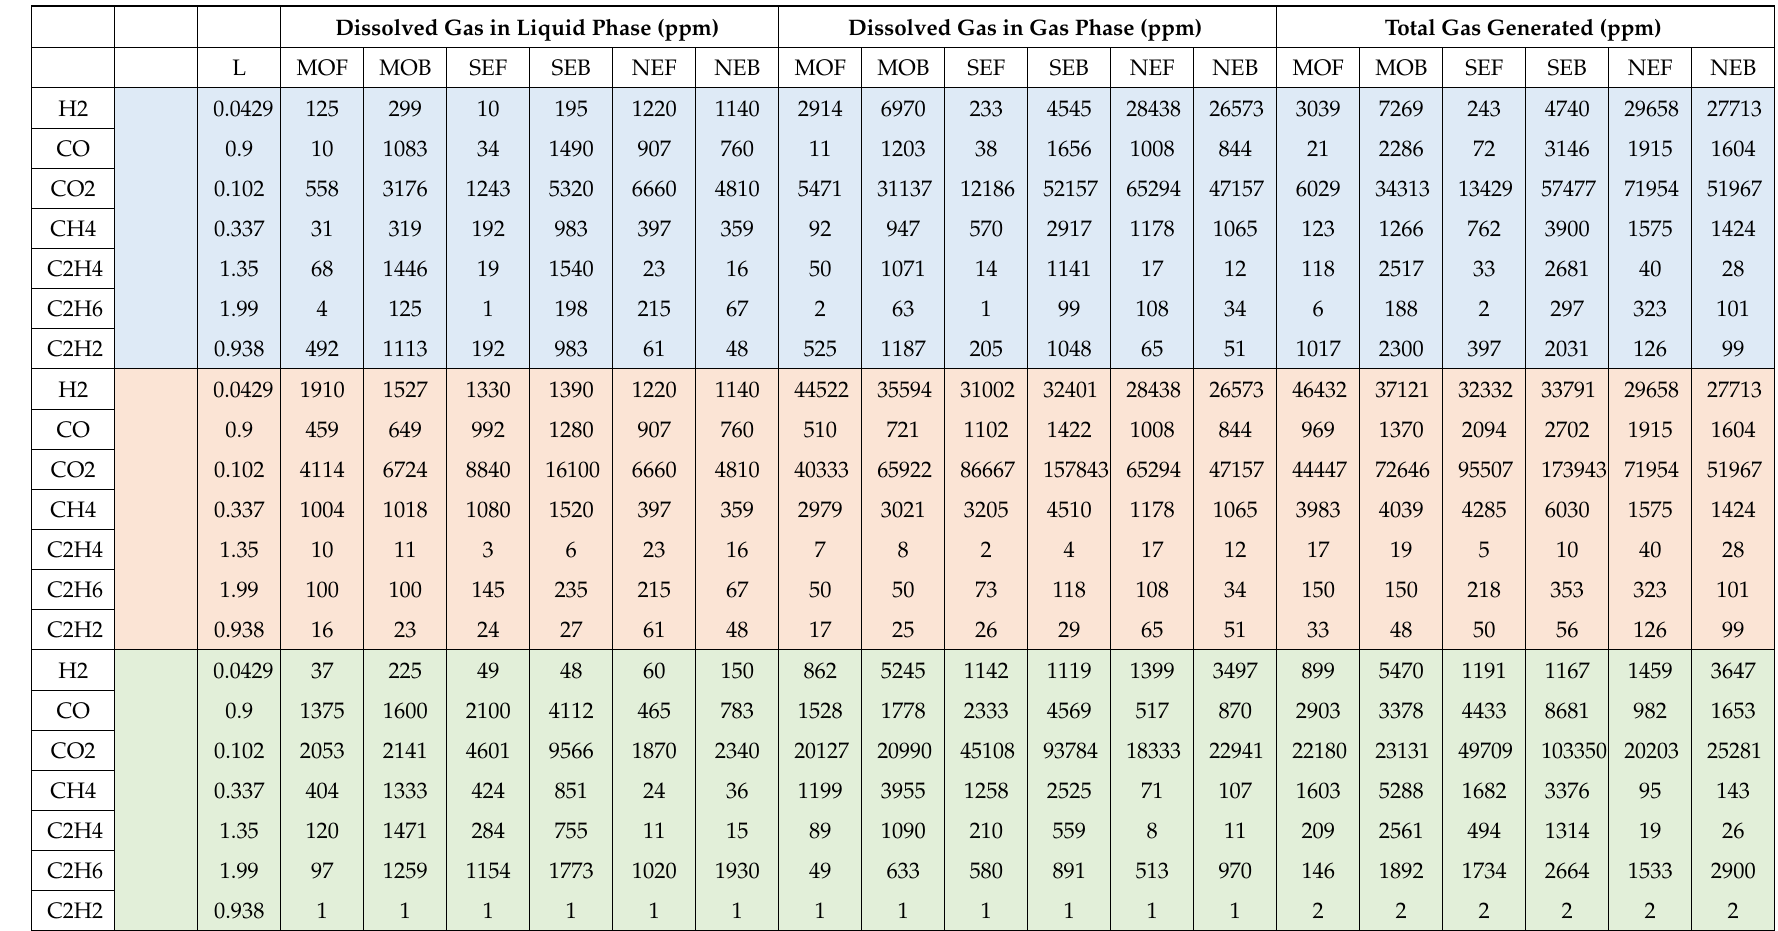
Table 6. Details of total gas generation at di ff erent fault conditions in various